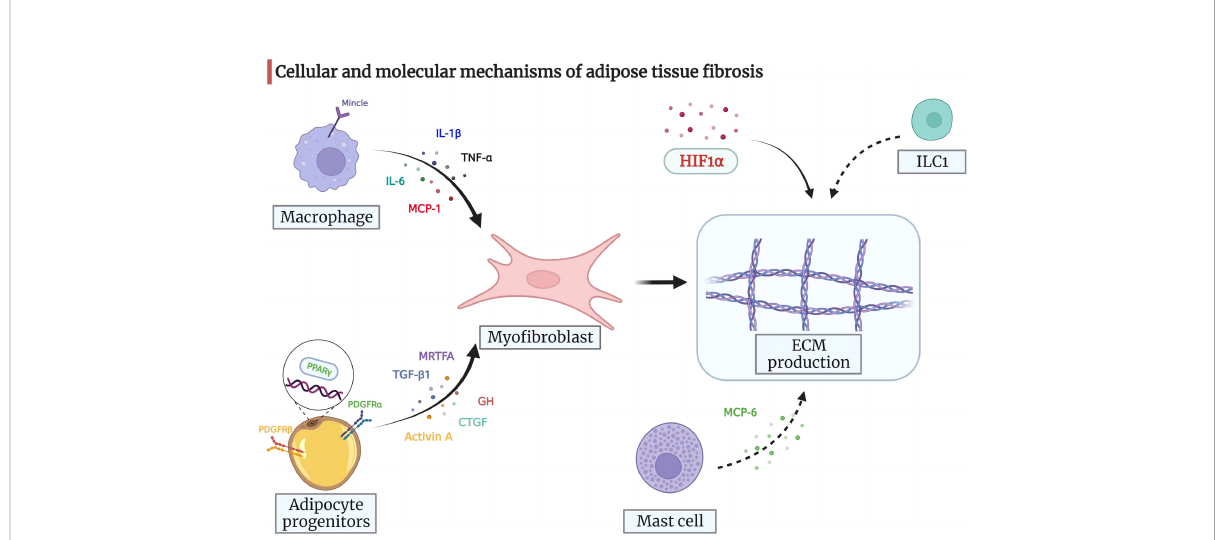
FIGURE 2 Cellular and molecular mechanisms of adipose tissue fi brosis. Myo fi broblasts are pivotal for ECM production and remodeling. Adipocyte progenitors can differentiate into myo fi broblasts, which then drive ECM synthesis. Adipocyte progenitors express both PDGFR a and PDGFR b . When PDGFR a signaling is activated, adipocyte progenitors synthesize ECM and function as pro fi brotic cells. PDGFR b inhibits the adipogenic potential of progenitors. The nuclear receptor PPAR g also regulates adipogenesis with anti- fi brotic potential. Moreover, TGF- b 1, activin A, CTGF, GH, and MRTFA may drive adipose progenitors to acquire a myo fi broblast phenotype and prevent differentiation into adipocytes under certain circumstances. The in fi ltrating macrophages in adipose tissue can release signals, such as IL-6, MCP-1, TNF- a , and IL-1 b , which attract fi broblasts and regulate adipose tissue fi brosis. In addition, macrophage-inducible C-type lectin (Mincle) modulates macrophage function and correlates with myo fi broblast activation and ECM remodeling. Mast cells secrete MCP-6 and induce collagen V expression, contributing to adipose tissue fi brosis and accelerating insulin resistance by inhibiting preadipocyte differentiation. ILC1 in adipose tissue induces fat fi brosis in an IFN- g -dependent manner. HIF1 a promotes adipose tissue fi brosis and is a potential therapeutic target for adipose tissue fi brosis and associated metabolic disorders. ECM, extracellular matrix; PDGF, platelet-derived growth factor; PPAR g , peroxisome proliferator-activated receptor-gamma; TGF- b 1, transforming growth factor-beta 1; CTGF, connective tissue growth factor; GH, growth hormone; MRTFA, myocardin-related transcription factor A; IL-6, interleukin-6; MCP-1, monocyte chemoattractant protein-1; TNF- a , tumor necrosis factor-alpha; IL-1 b : interleukin-1beta; MCP-6, mast cell protease 6; ILC1s, group 1 innate lymphoid cells; IFN- g , interferon-gamma; HIF1 a , hypoxia-inducible factor